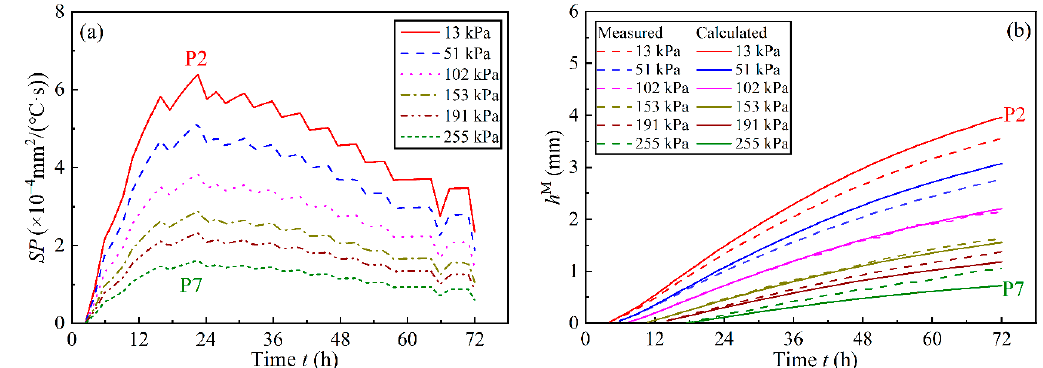
Figure 10. ( a ) Segregation potential under external pressure calculated by Equation (7), ( b ) comparison of calculated and measured frost heave amounts.